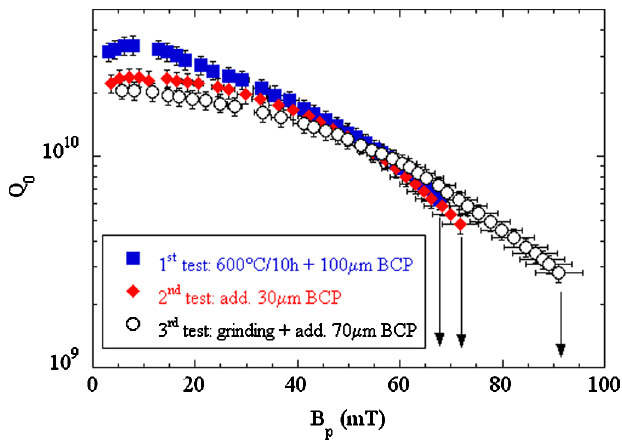
FIG. 1. Q vs B p at 1.7 K after successive material removal 0 showing a strong medium-field Q slope.